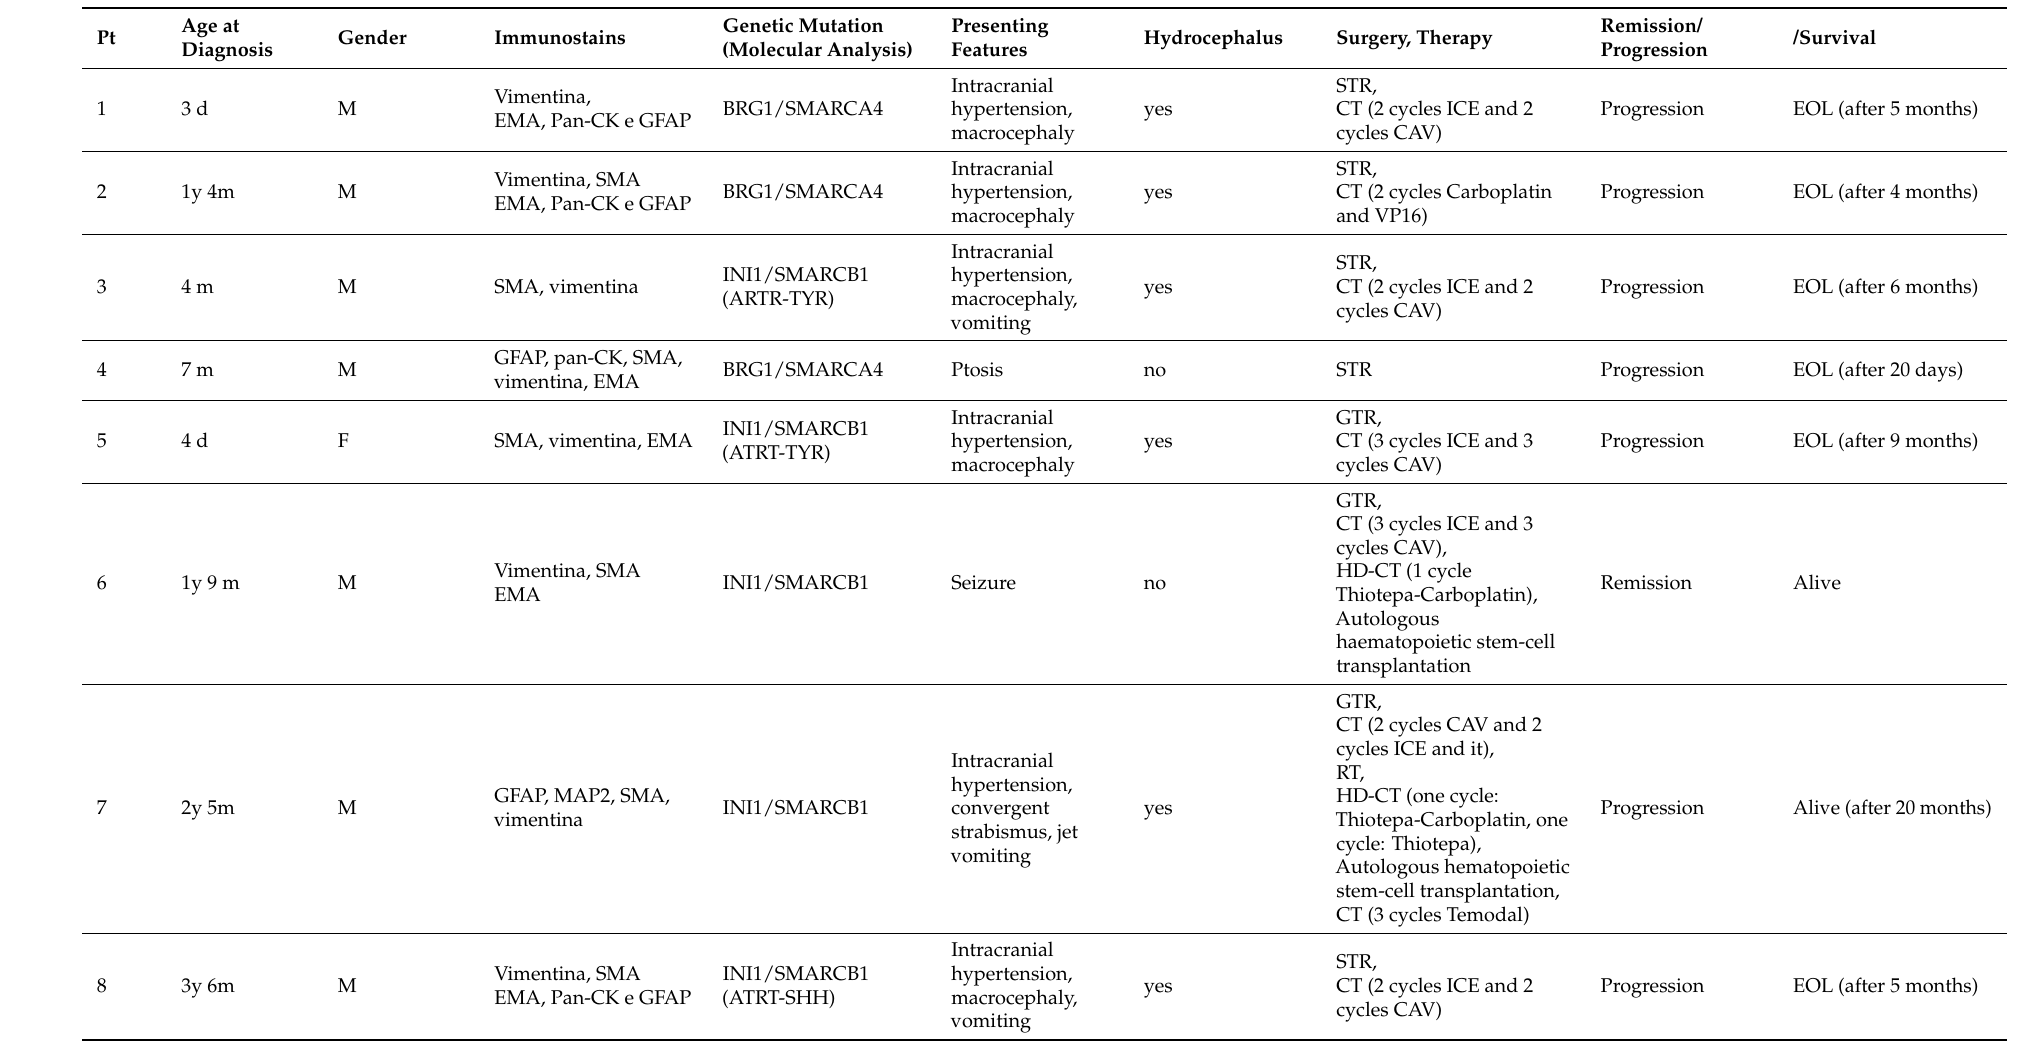
Table 1. Clinical features and outcome in 11 patients with atypical teratoid rhabdoid